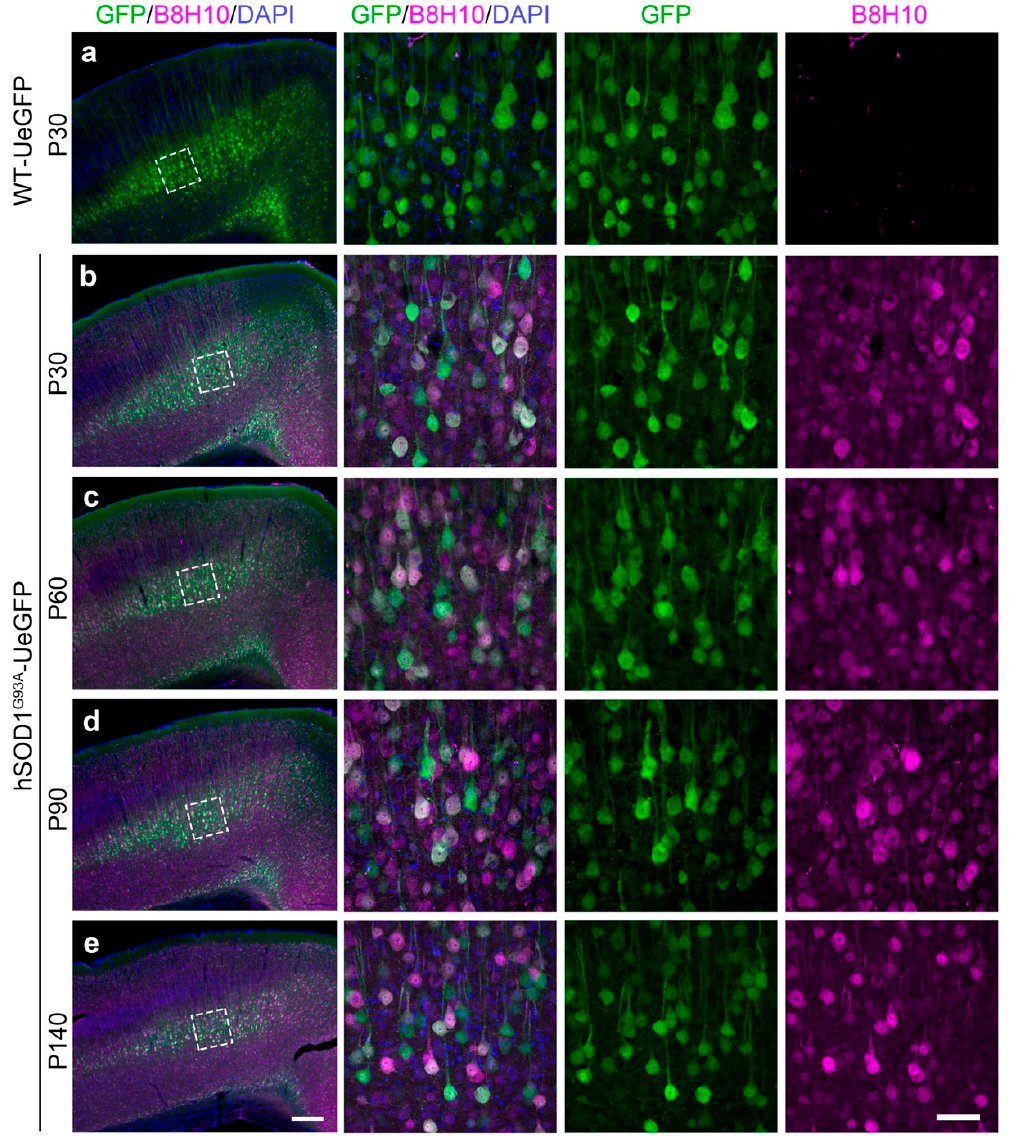
Figure 2. Misfolded SOD1 protein in the primary motor cortex. ( a ) B8H10 antibody does not detect any misfolded SOD1 protein in the primary motor cortex of WT-UeGFP control mice; ( b – e ) misfolded SOD1 protein can be detected in the primary motor cortex of hSOD1 G93A -UeGFP mice by the B8H10 antibody at P30 ( b ), P60 ( c ), P90 ( d ), and P140 ( e ). Boxed areas enlarged in the right panels. Scale bar, 250 μ m (left, low mag) and 50 μ m (right, high mag).